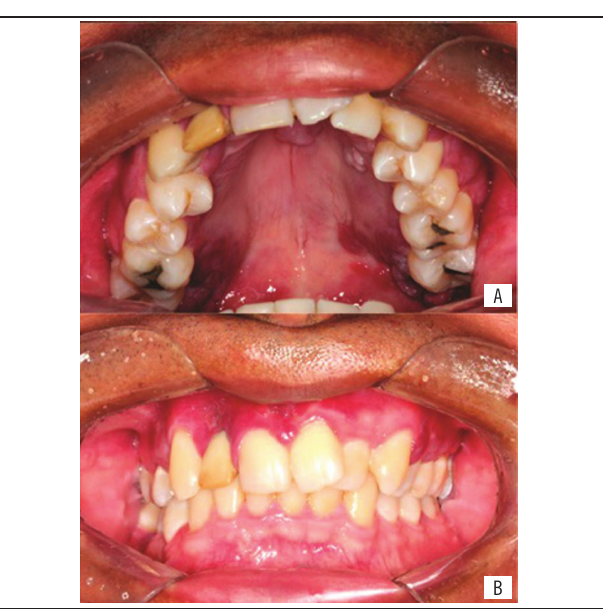
figurE 5 − Patient’s oral aspect after HAART A) significant regression of intraoral lesions is observed after 11 months of treatment with antiretroviral drugs; B) patient’s oral aspect after HAART. HAART: highly active antiretroviral